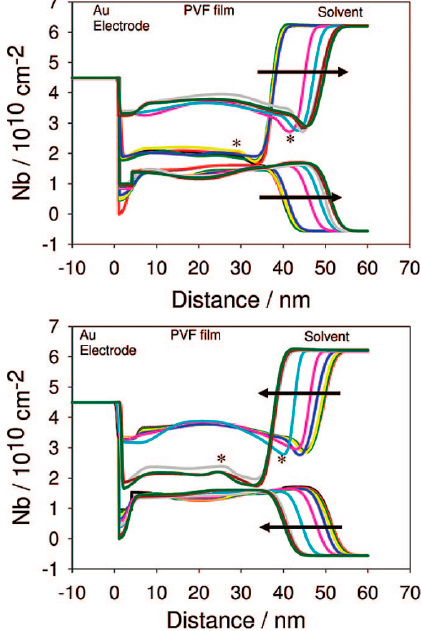
Figure 9. Fitted SLD profiles showing the exodus and ingress of solvent into the uppermost section of a PVF layer deposited on an Au film as potential is cycled from 0.15 V–0.60 V (top) and back again (bottom). Reproduced with kind permission from [114], ACS Publications, 2008.